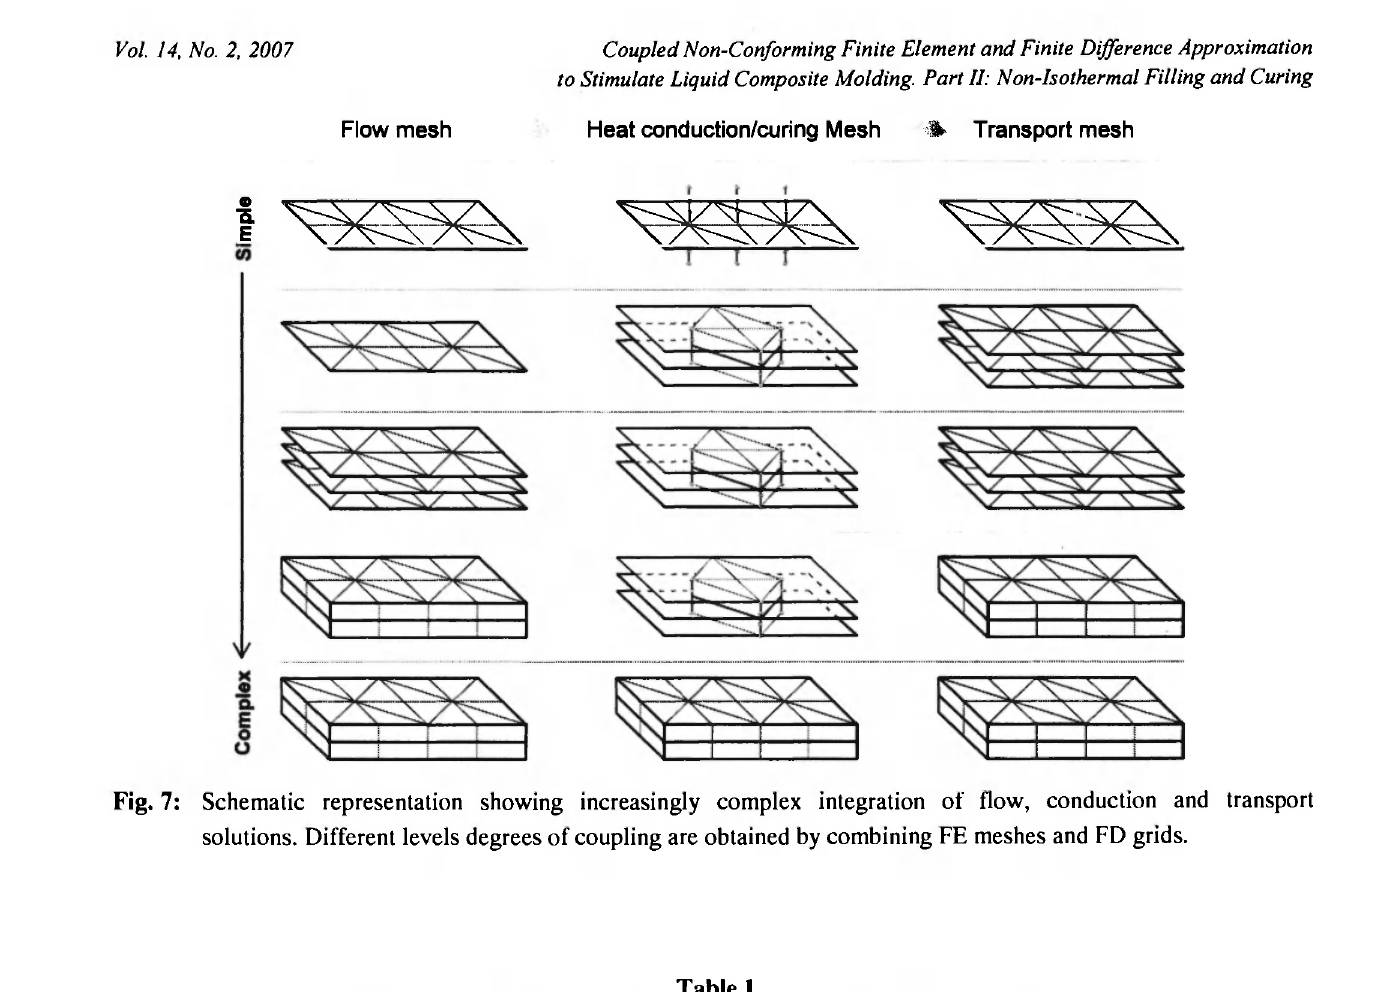
Different levels of integration of flow/thermal/curing formulations depending on the level of mesh